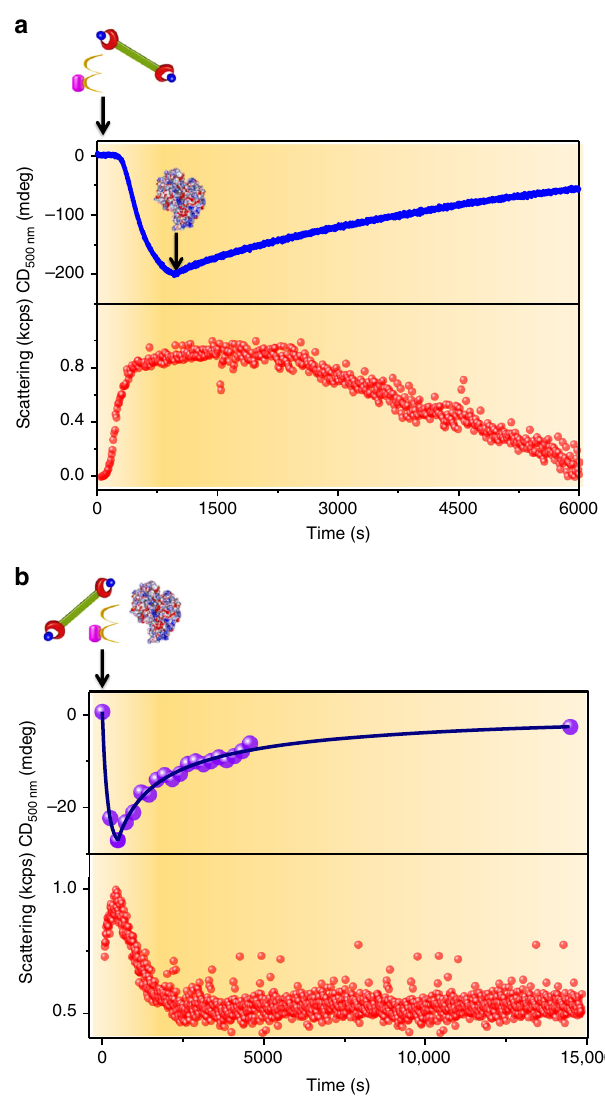
Fig. 5 Enzyme mediated transient assembly of 1. a Passive assembly of ATP- 1 indicating growth followed by disassembly after apyrase is added into the elongated solution monitored using the changes in CD and scattering (0.9 equiv. ATP, 7.2 U apyrase), b active self-assembly of ATP- 1 , wherein the changes in CD and scattering indicates a transient self-assembly via temporal control over the ATP hydrolysis using apyrase (6.4 equiv. the rate of elongation ( k e(seeded) ) decreases with increasing [ 1 ]/[S] ratio (Supplementary Fig. 31 and Supplementary Table 5). In